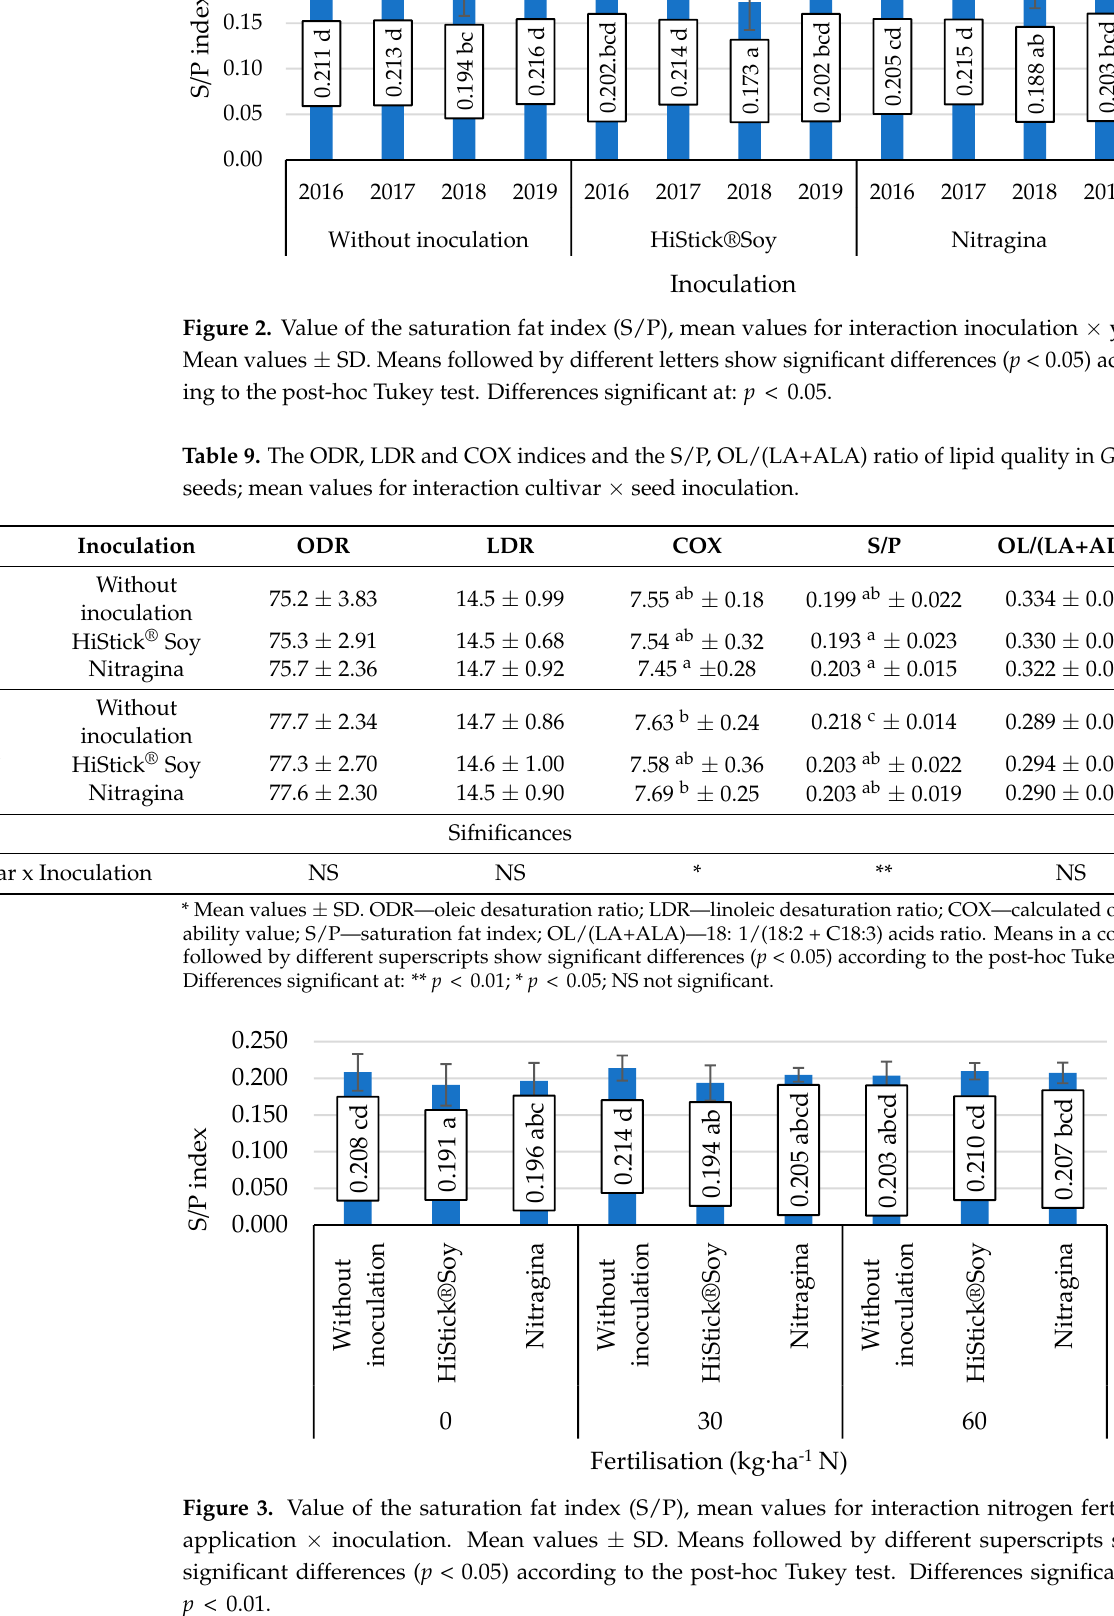
Table 9. The ODR, LDR and COX indices and the S/P, OL/(LA+ALA) ratio of lipid quality in G. max seeds; mean values for interaction cultivar × seed inoculation.